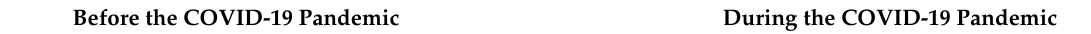
Table 3. Factors associated with frequent ED users before (February 2019–January 2020) and during the COVID-19